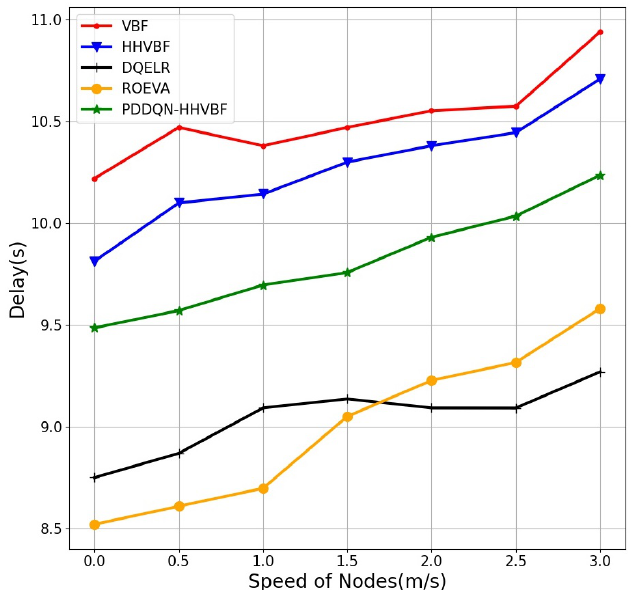
Figure 14. The end-to-end delay of VBF, HHVBF, DQELR, ROEVA, and PDDQN-HHVBF protocol in different speed of nodes.